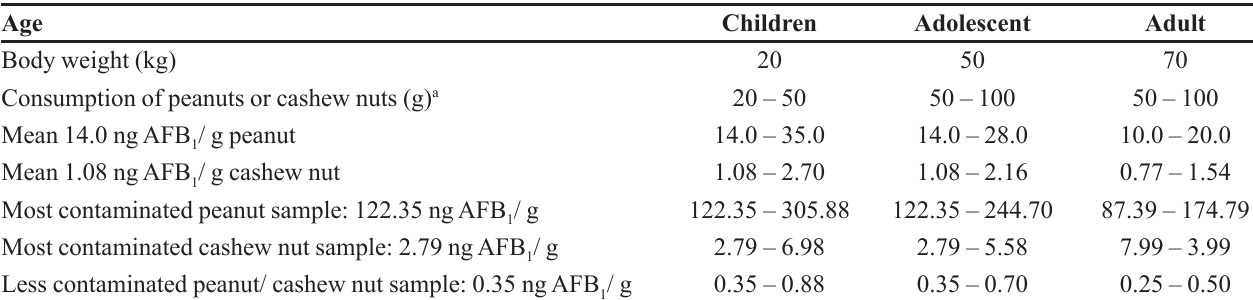
(ng AFB /kg bw/day) 1 1